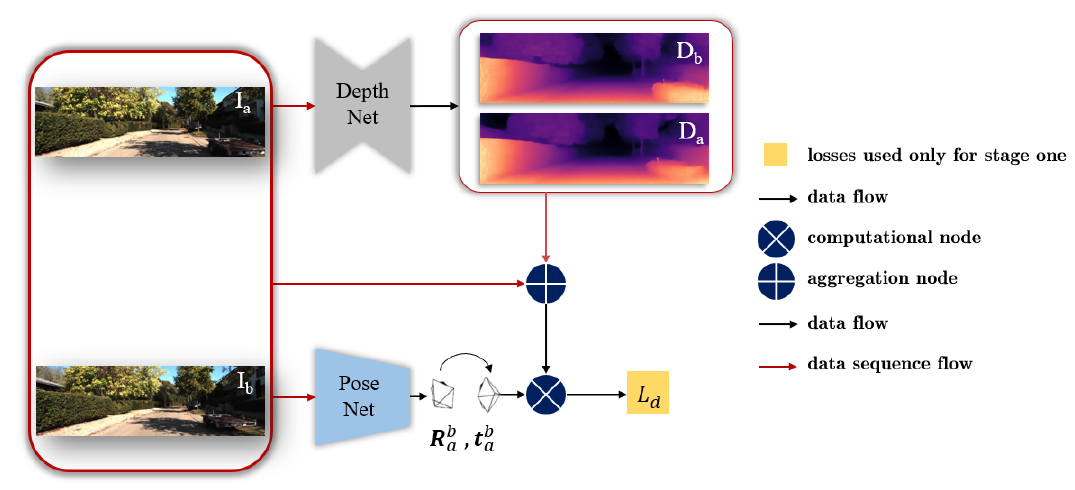
Figure 3. The unsupervised depth learning framework in our approach. Detailed description about its structure can be seen in the text.